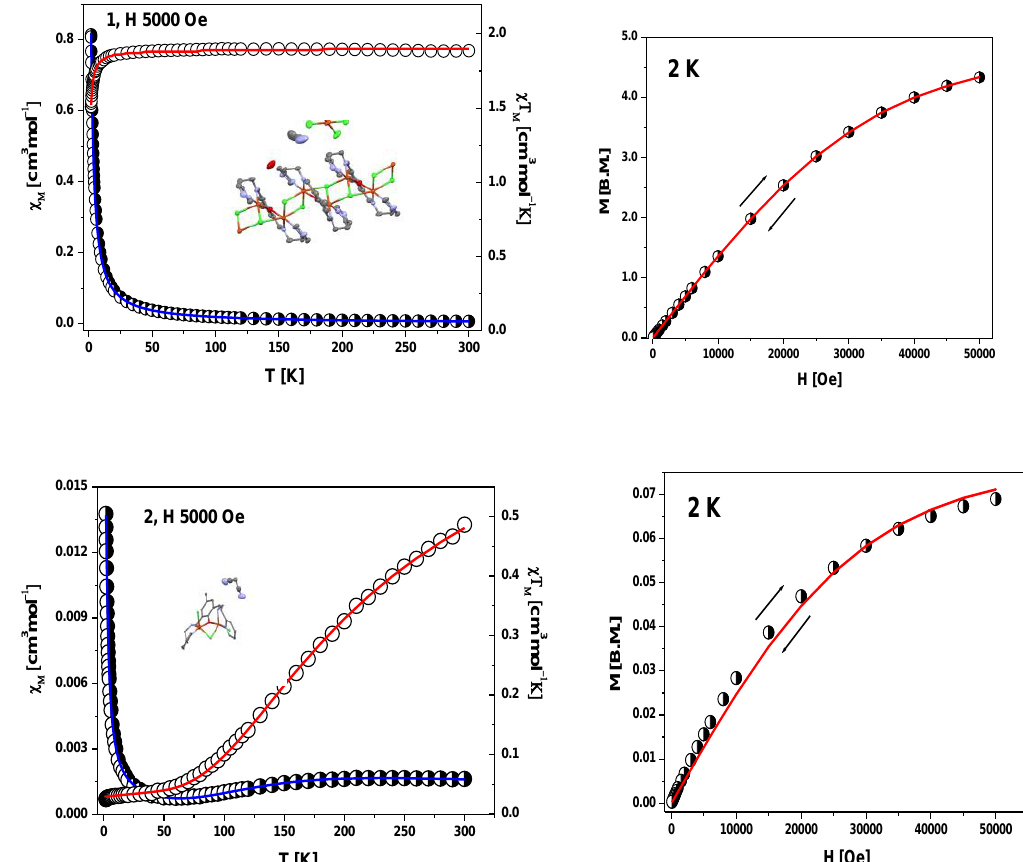
Figure 6. DC magnetic data for 1 and 2 ; left panels: temperature dependence of χ M and of the χ M T